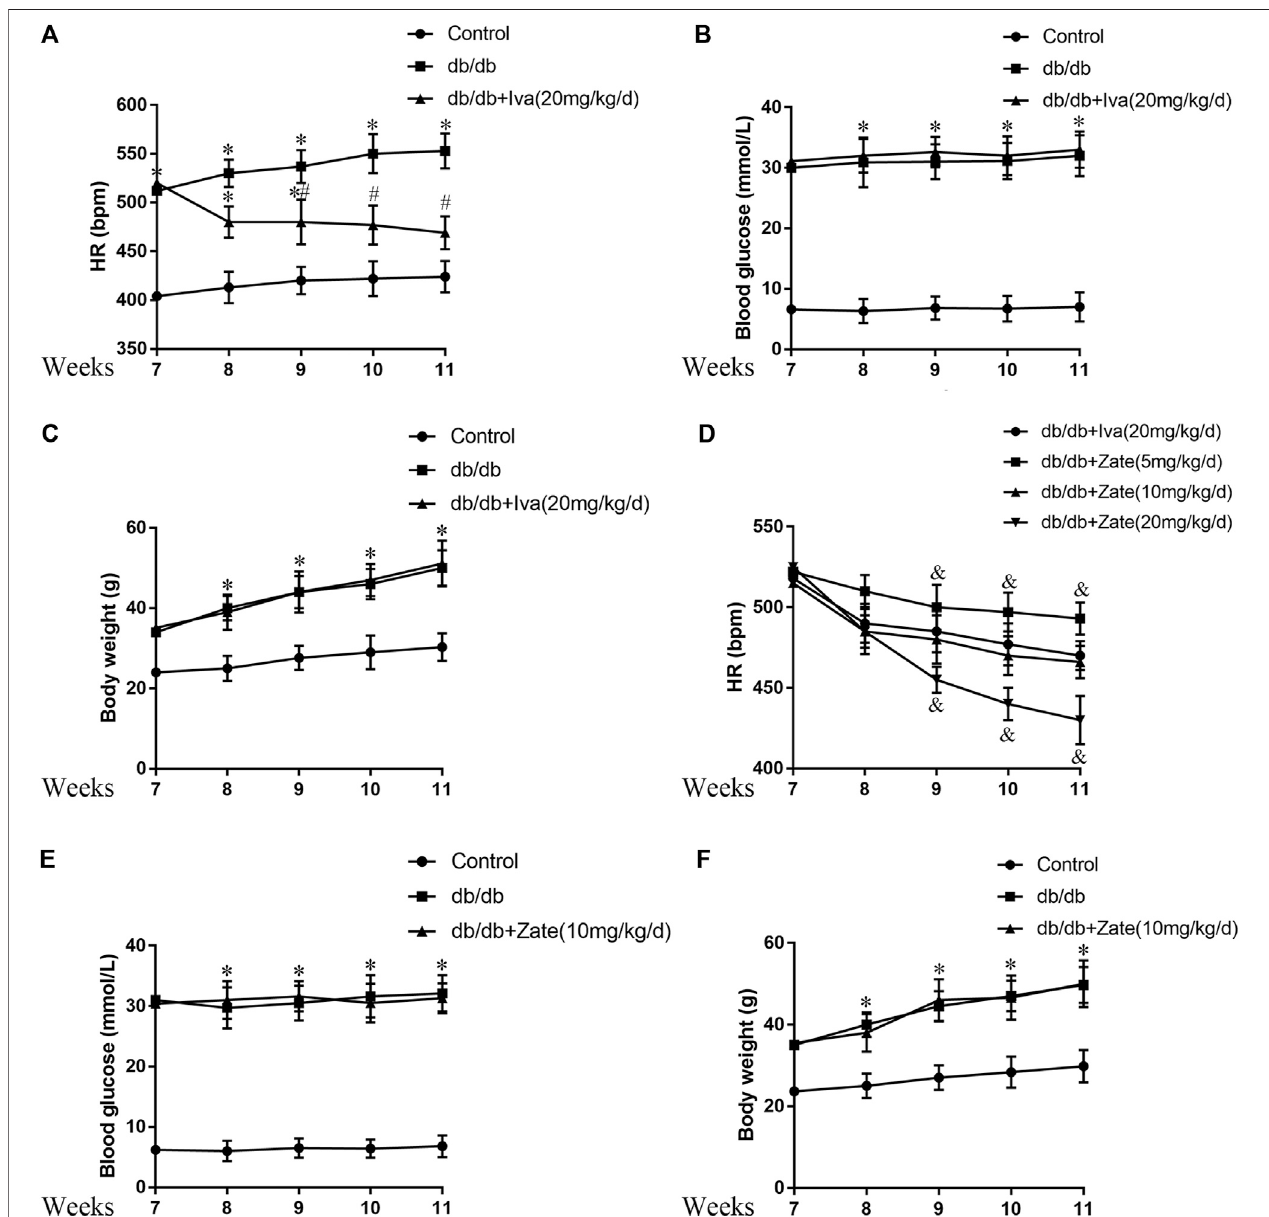
FIGURE5 | Effects ofivabradine and zatebradineon heart rate (HR) and biometric parameters (A) During treatmentwithor withoutivabradine for 7 – 11 weeks, the mean HR of mice was recorded by electrocardiography (ECG) (B and C) Mice were treated as described in (A) and their blood glucose concentration and body mass weremeasured (D) Duringtreatmentwithivabradineorzatebradineattheindicateddosesfor7 – 11 weeks,themeanHRofmicewasrecordedbyECG (EandF) During treatment with 10 mg/kg/day zatebradine for 7 – 11 weeks, the blood glucose concentration and body mass of the mice were measured. Data are presented as mean ± SEM ( n (cid:2) 8 – 10). p -values were calculated using one-way ANOVA with Tukey multiple comparison test. * p < 0.05, compared to the Control group; # p < 0.05, compared to the db/db mice group; & p < 0.05, compared to the db/db + Iva (20 mg/kg/d) group or the db/db + Zate (10 mg/kg/d) group.